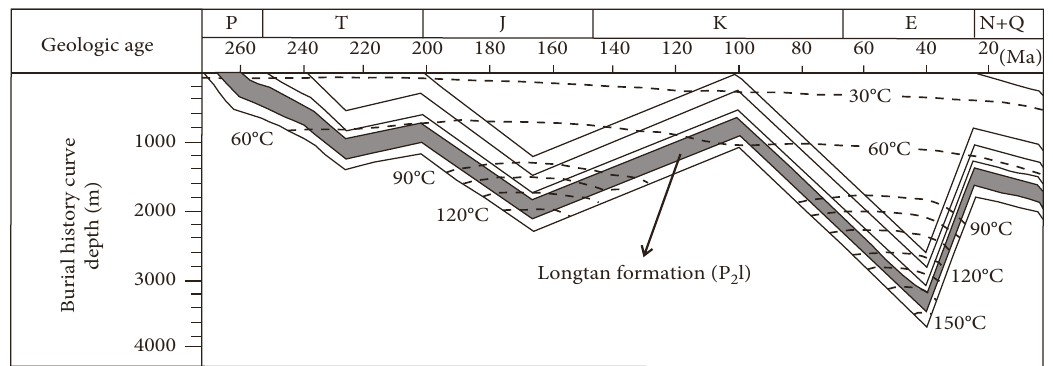
l) in the Huangqiao area (from Sy [42]). 2